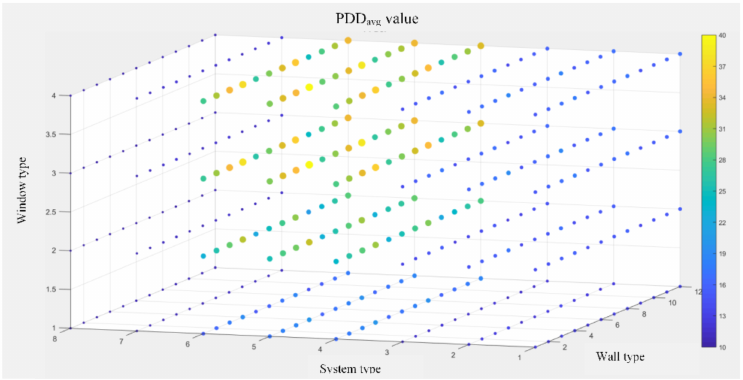
Figure 7. The values of the PPD avg objective function in the space of decision variables (wall type, window type and system type).